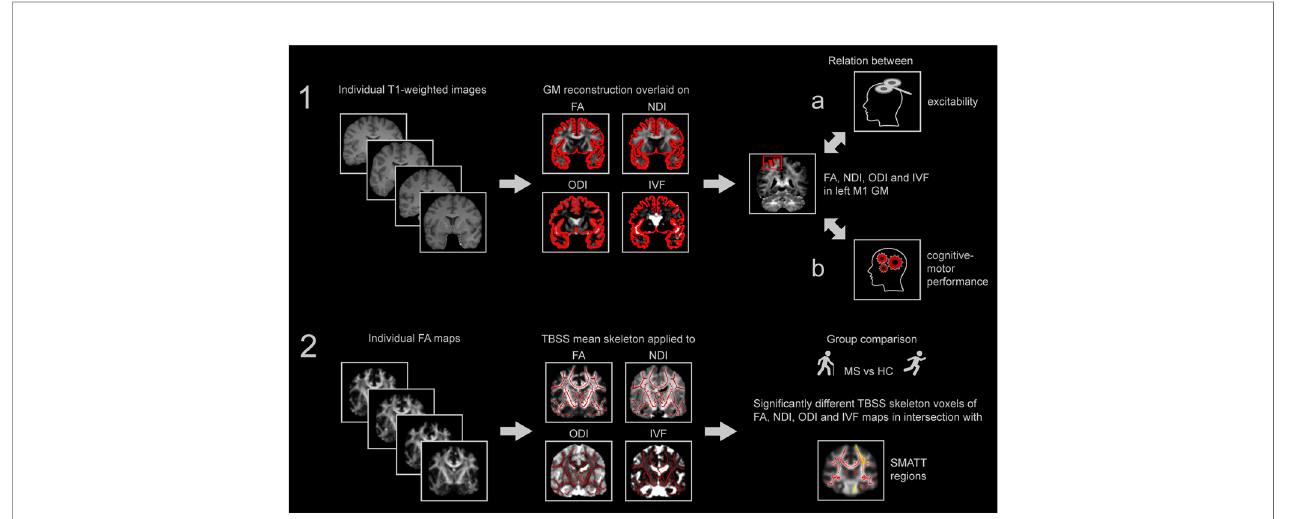
FIGURE 1 | Study pipeline. (1) T1-weighted images were used for reconstruction of the GM that was individually coregistered to FA, NDI, ODI and IVF maps. Motor threshold as measure of excitability was regressed on average FA, NDI, ODI and IVF within the GM of left M1 (1a). Scores of cognitive-motor performance were similarly regressed on average FA, NDI, ODI and IVF within the GM of left M1 (1b). (2) Individual FA maps of all participants were used to compute the TBSS mean skeleton that was applied to FA, NDI, ODI and IVF for comparisons of MS and HC group. Percentage of intersecting signi fi cantly different voxels with regions of the sensorimotor area tract template (SMATT) (27) were determined for each diffusion parameter. FA, fractional anisotropy, NDI, neurite density index, ODI, orientation dispersion index, IVF, isotropic volume fraction, MS, multiple sclerosis, HC, healthy control, TBSS, tract-based spatial statistics, SMATT, sensorimotor area tract template, GM, grey matter, M1, primary motor